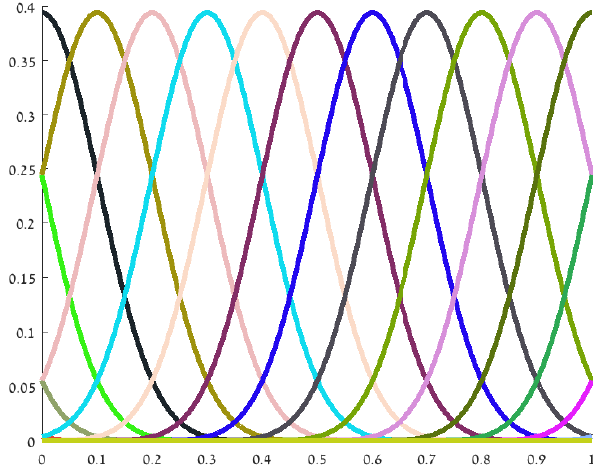
Figure 1. The B-splines used in Example